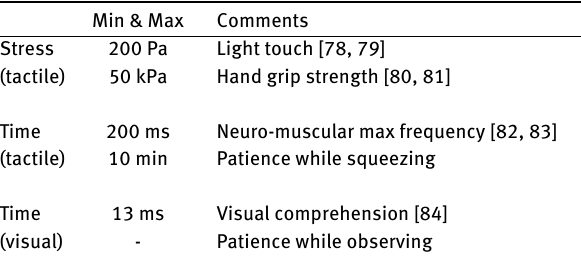
Table 1: Perception limits relevant to human handling of putties and gels. See text for